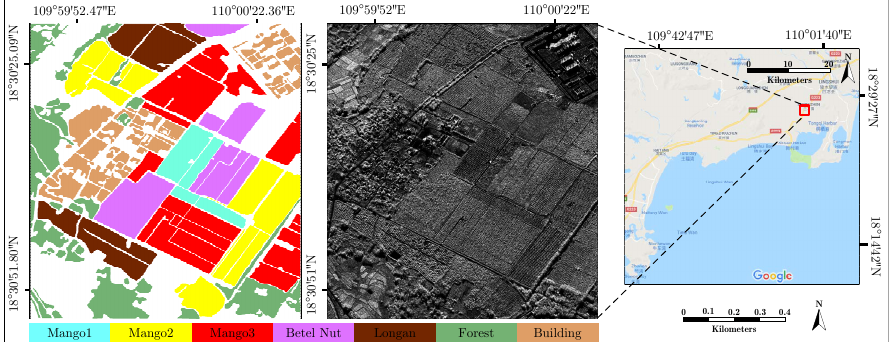
Figure 8. Overview of the Orchard data. The unidentifiable class is shown in white in a ground truth